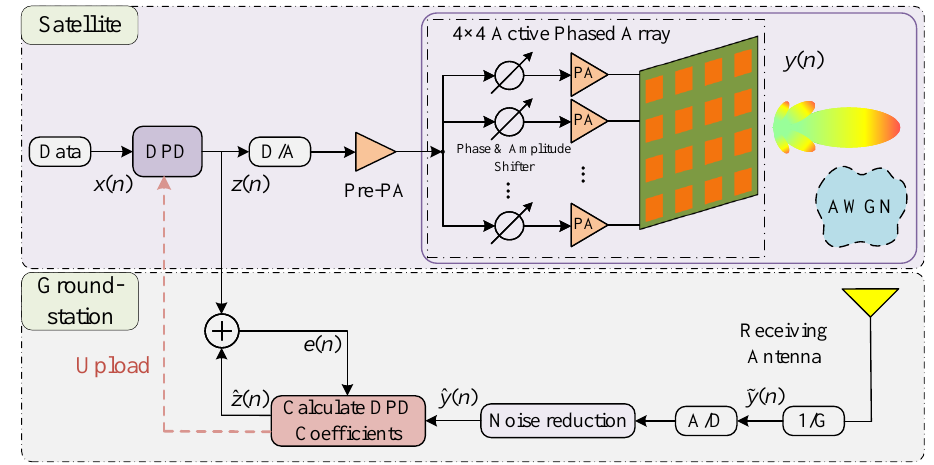
Figure 6. The indirect learning structure of the proposed JSG-DPD technique. Notably, another communication link is not required because the pilot signal z ( n ) is only a fixed segment of the signal known to the ground station for the purpose of calculating the DPD coefficients. Therefore, the proposed JSG-DPD indirect learning structure does not occupy additional space-borne